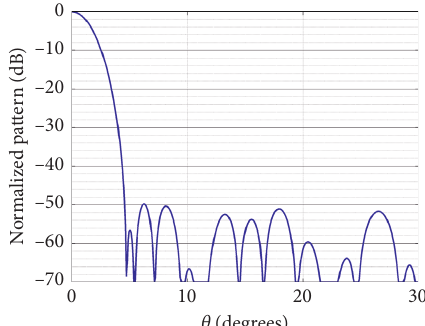
Figure 16: The two-way array pattern for N